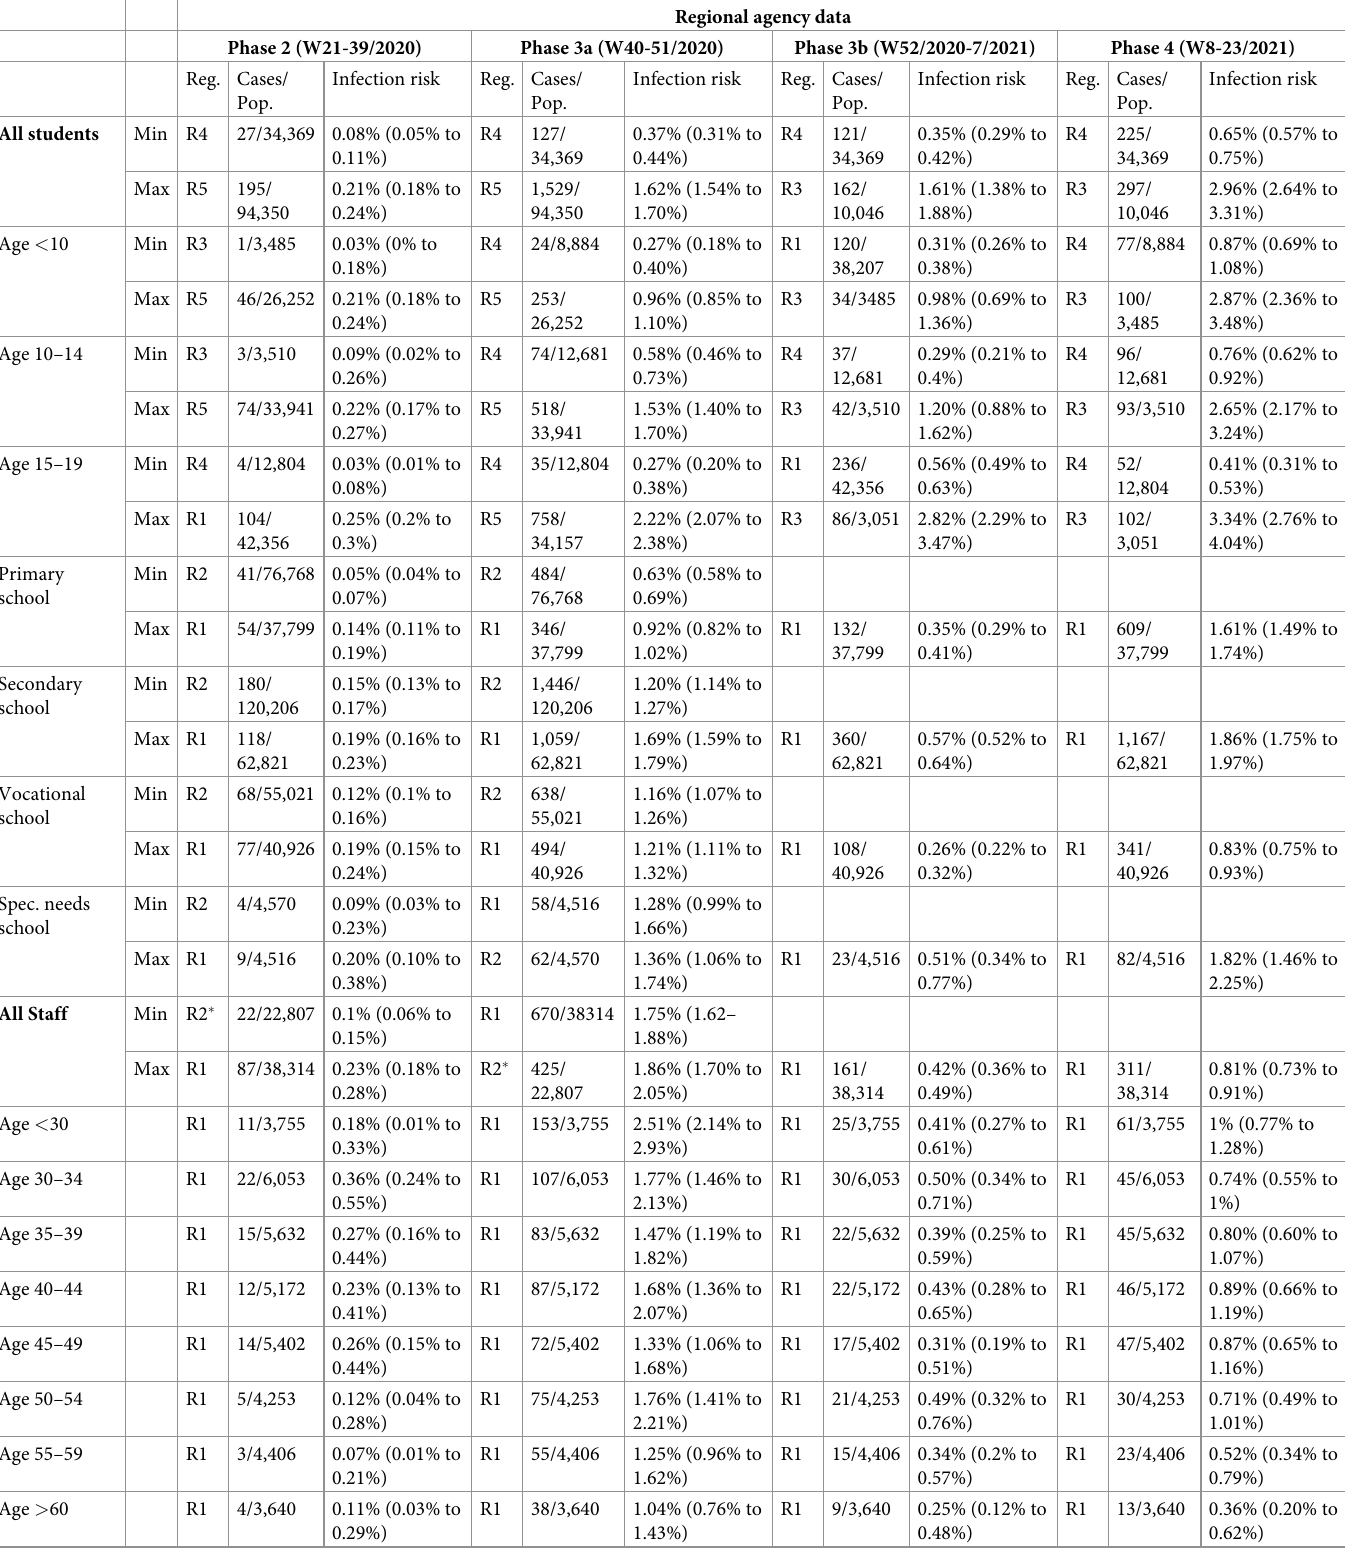
Table 4. Risk of infection over pandemic phases with minima and maxima risk per federal state/county according to regional agency